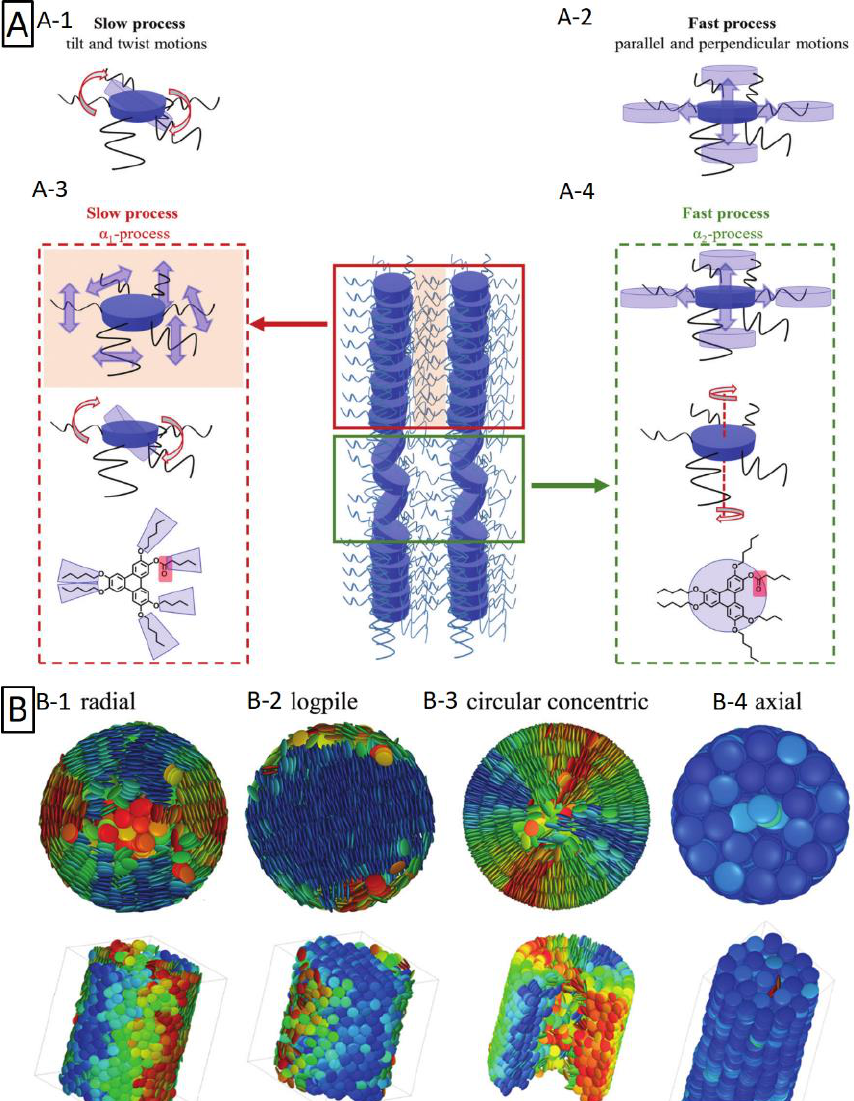
Figure 15. Motion and possible distribution of discotic liquid crystals in nanopore-limited space. ( A ) Illustration of ( A-1 ) tilt and twist and ( A-2 ) parallel and perpendicular motion of single discotic molecule. Cooperative molecular fluctuations and related changes to the column packing are assigned to ( A-3 ) α 1 and ( A-4 ) α 2 processes. Blue highlight on the structural formula represent parts assigned to glassy dynamics while red coloration represent parts of the molecule that enable to sense this glassy dynamic through Broadband Dielectric Spectroscopy. Reprinted (adapted) with permission from [200]. Copyright 2019 The Royal Society of Chemistry. ( B ) Monte Carlo simulation showing snapshots of columnar discotic order in cylindrical pores ( B-1 – B-4 ) in top- and side-view for different arrangement of discotic particles. Reprinted (adapted) with permission from [201]. Copyright 2019 The Royal Society of Chemistry.